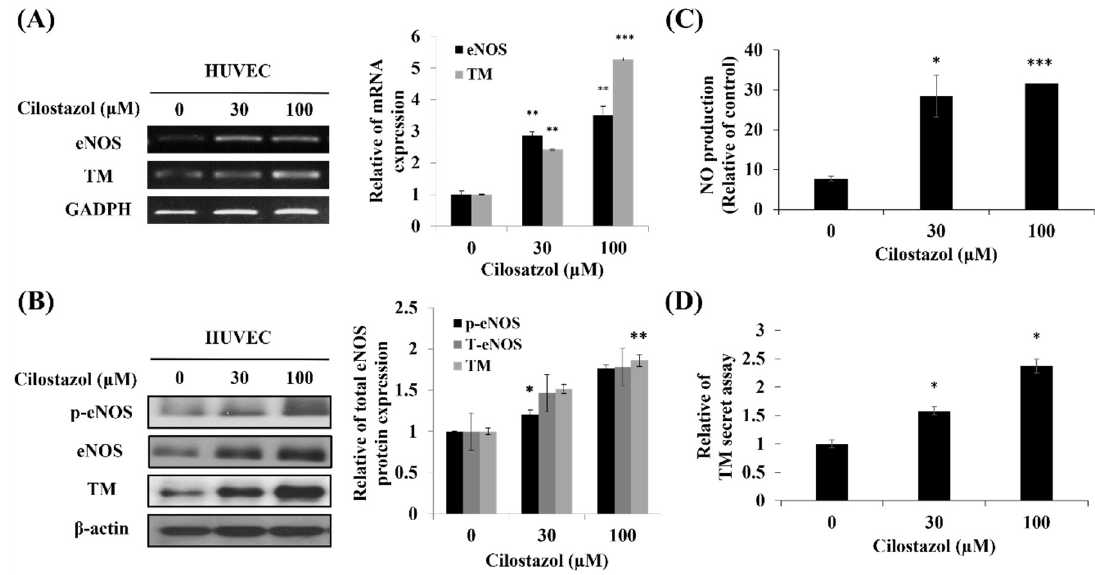
Figure 3. Cilostazol increases endothelial nitric oxide synthase (eNOS) expression and thrombomodulin (TM) at the RNA and protein levels. The HUVECs were incubated with cilostazol (0, 30, or 100 μM) for 24 h. The expression of eNOS and TM on mRNA and p -eNOS, total eNOS, and TM on protein expression levels was assessed using ( A ) PCR and ( B ) Western blot, respectively. ( C ) The nitric oxide (NO) production and ( D ) TM secretion was detected using flow cytometry with 4,5-diaminofluorescein and ELISA, respectively. Data are expressed as mean ± SD of experiments conducted in triplicate. * p < 0.05, ** p < 0.01, and *** p < 0.001 compared to the untreated group.